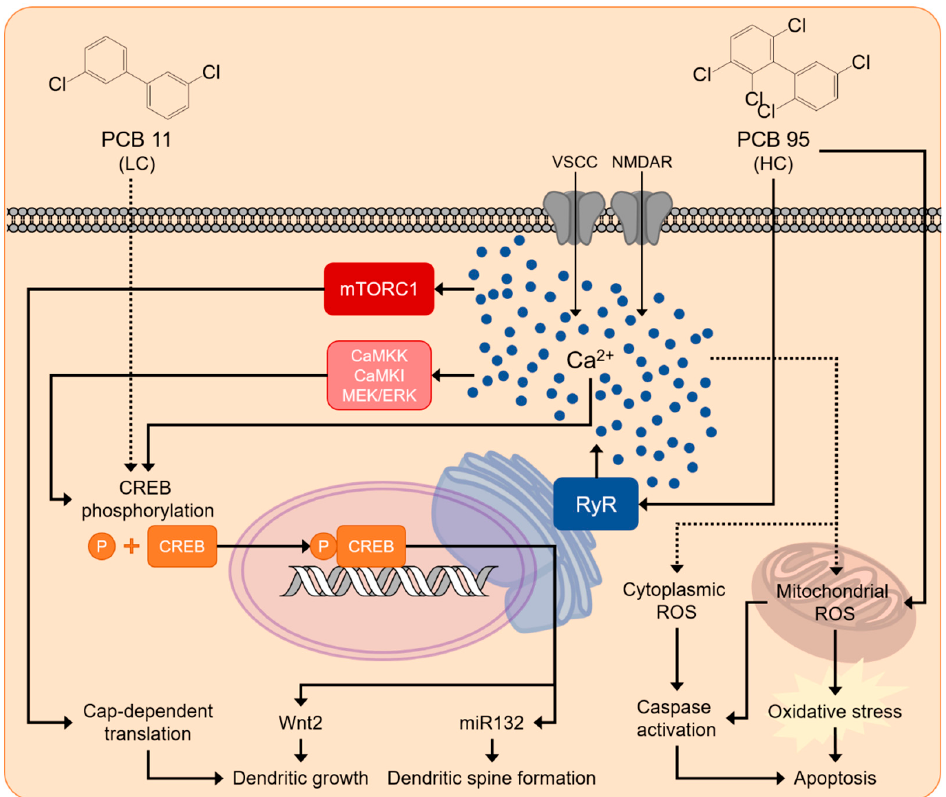
Figure 2. Experimental evidence supports a mechanistic model in which NDL PCBs alter neuronal morphogenesis and promote neuronal apoptosis via Ca 2+ -dependent and/or ROS-dependent mechanisms. CaMK, Ca 2+ /calmodulin-dependent protein kinase; CREB, cAMP response element-binding protein; HC, highly chlorinated; LC, lightly chlorinated; MEK/ERK, mitogen-activated protein kinase kinase/extracellular signal-regulated kinase; NMDAR, NMDA receptor; RyR, ryanodine receptor; VSCC, voltage-sensitive calcium channel. Solid lines indicate that experimental evidence directly links the upstream and downstream event; in contrast, dotted lines indicate a link but the intervening steps have yet to be identified.